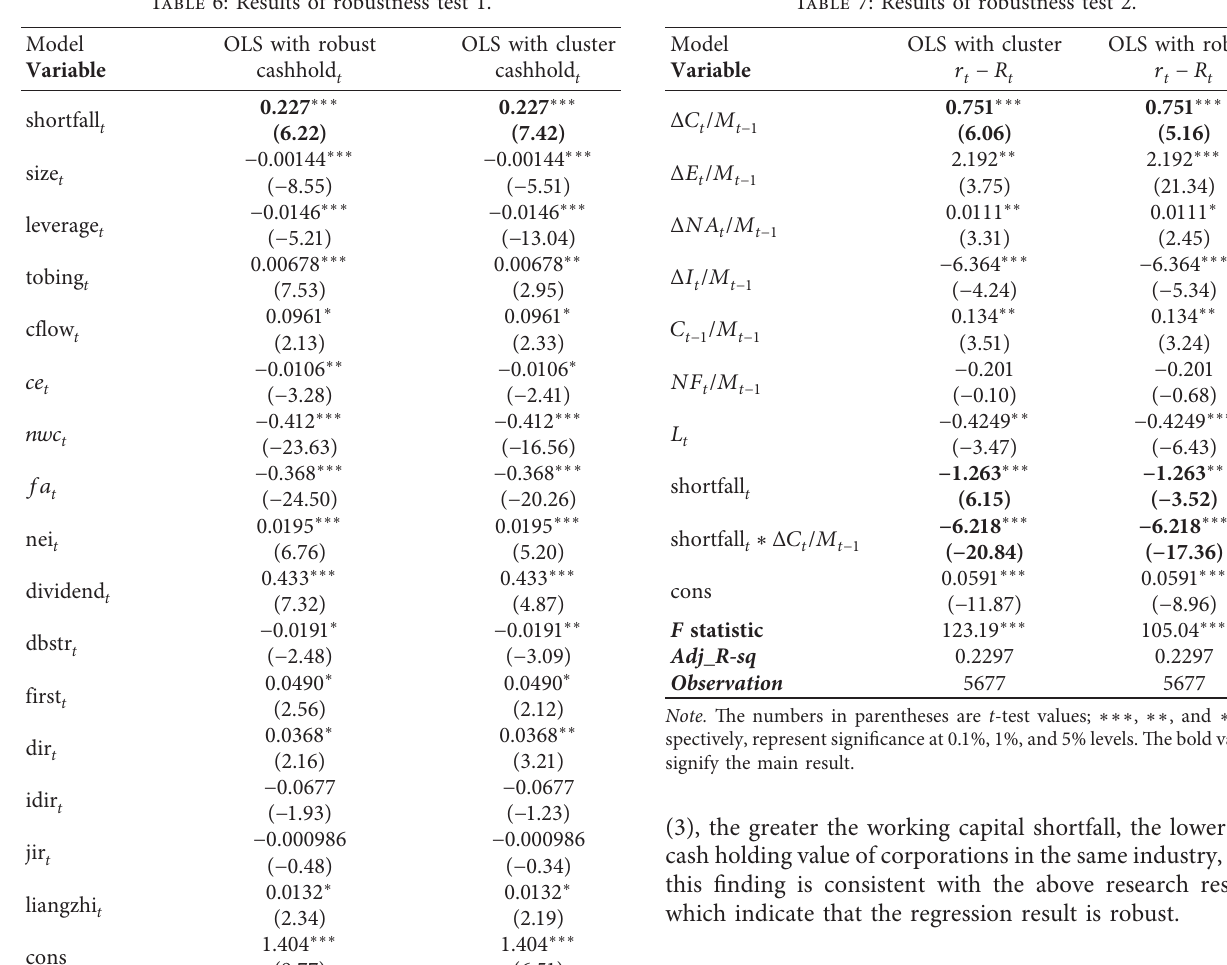
Table 6: Results of robustness test 1. Table 7: Results of robustness test